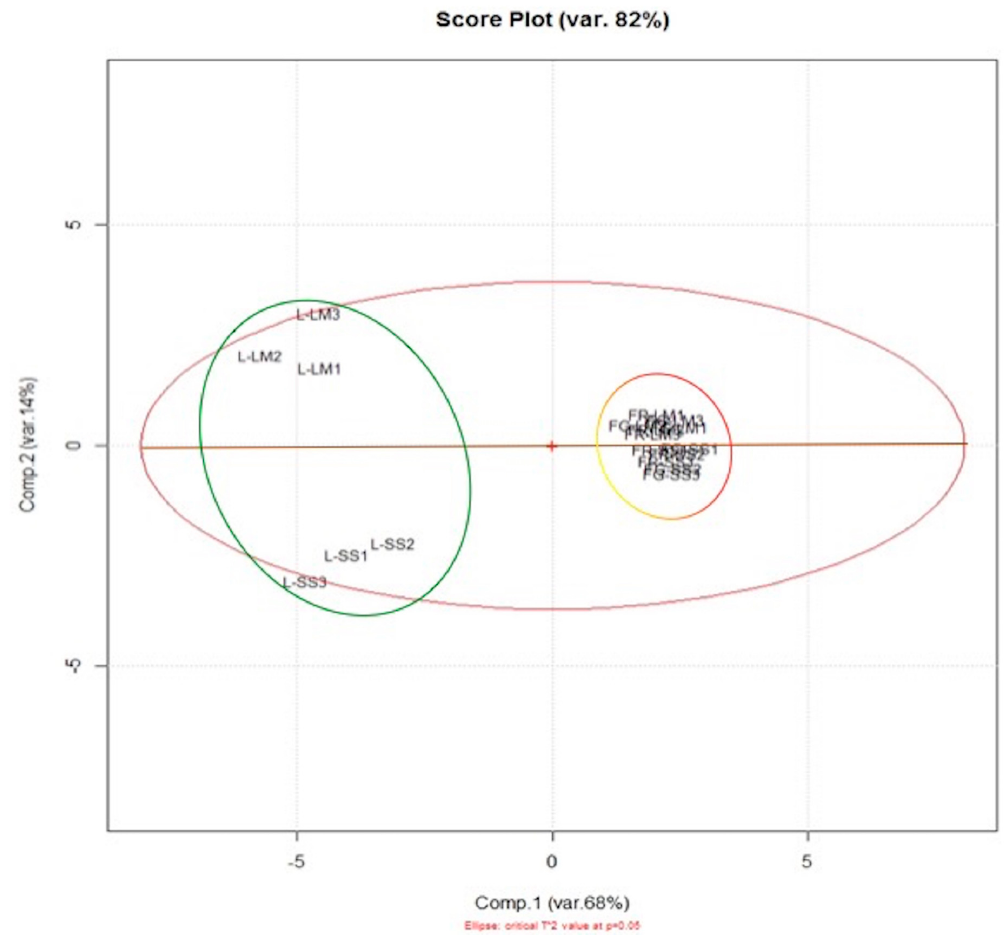
Figure 2. Score plot obtained from HPTLC data. (L = Leaves; FR = Red Fruit; FG = Yellow Fruit; SS = Sassari; LM = La Maddalena).